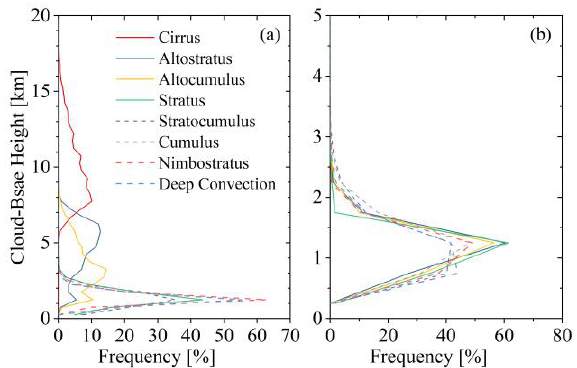
Figure 6. Occurrence frequencies of cloud base height s for eight cloud types: (a) Non-precipitation cloud; (b) precipitation cloud.